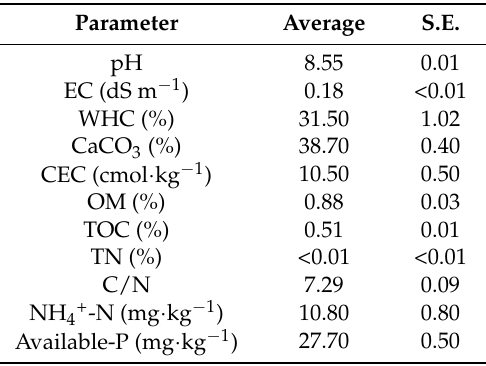
Table 2. Basic chemical properties of the soil used in the experiment. Mean value and standard error (S.E.) of 3